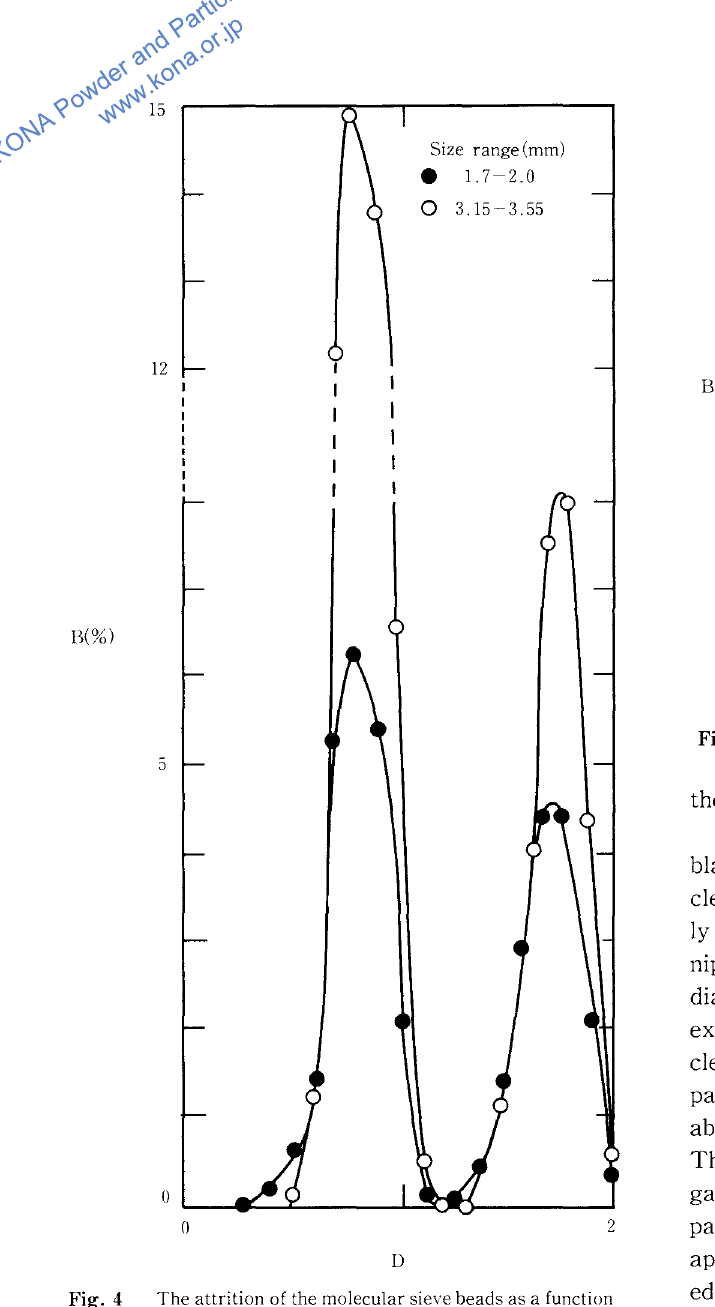
The attrition of the molecular sieve beads as a function of D.